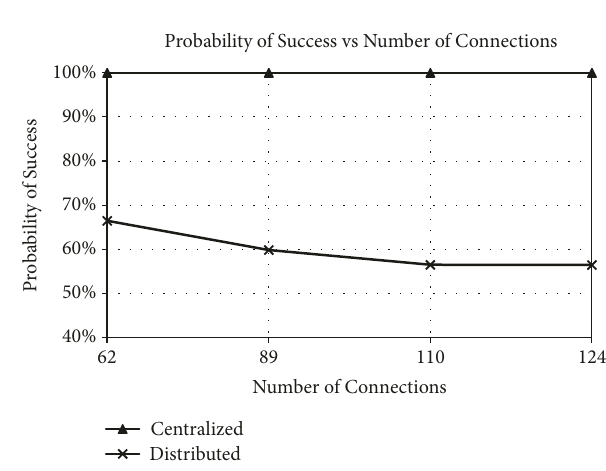
Figure 10: Probability of success vs number of connections in Germany topology.